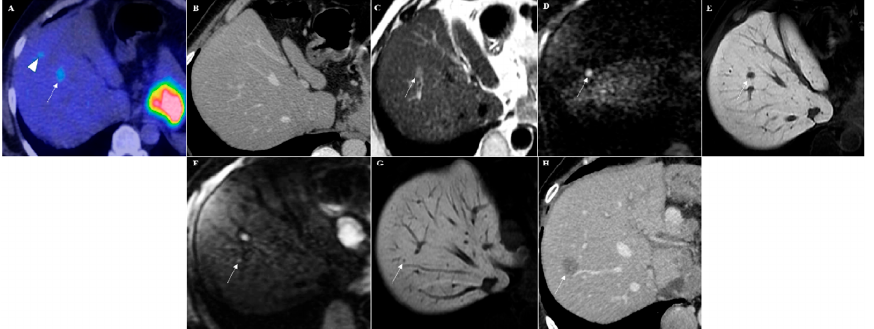
Figure 1. A 61-year-old male with a clinical history of gastric cancer. ( A ) 18-fluorideoxyglucose positron emission tomography ( 18 FDG-PET) image shows two focal lesions in the segment VIII of the liver with increased uptake (SUVmax 4.7) (arrowhead and arrow). ( B ) In the axial computed tomography (CT) scan image, no suspicious lesions were visible. Di ff usion-weighted imaging (DWI)-Gd-EOB-DTPA magnetic resonance imaging (MRI) examination showed only one slight hyperintense focal lesion on T2-weighted images (arrow in ( C )) with strong hyperintensity in di ff usion-weighted image (arrow in ( D )) and hypointensity during the hepatobiliary phase (arrow in ( E )), suspected for a liver metastasis. Moreover, a very small (2 mm) focal lesion with hyperintensity on di ff usion-weighted image (arrow in ( F )) and hypointensity during the hepatobiliary phase (arrow in ( G )) was also detectable cranially in the same liver segment. An axial contrast-enhanced CT scan performed after six months confirmed this hepatic metastasis (arrow in ( H